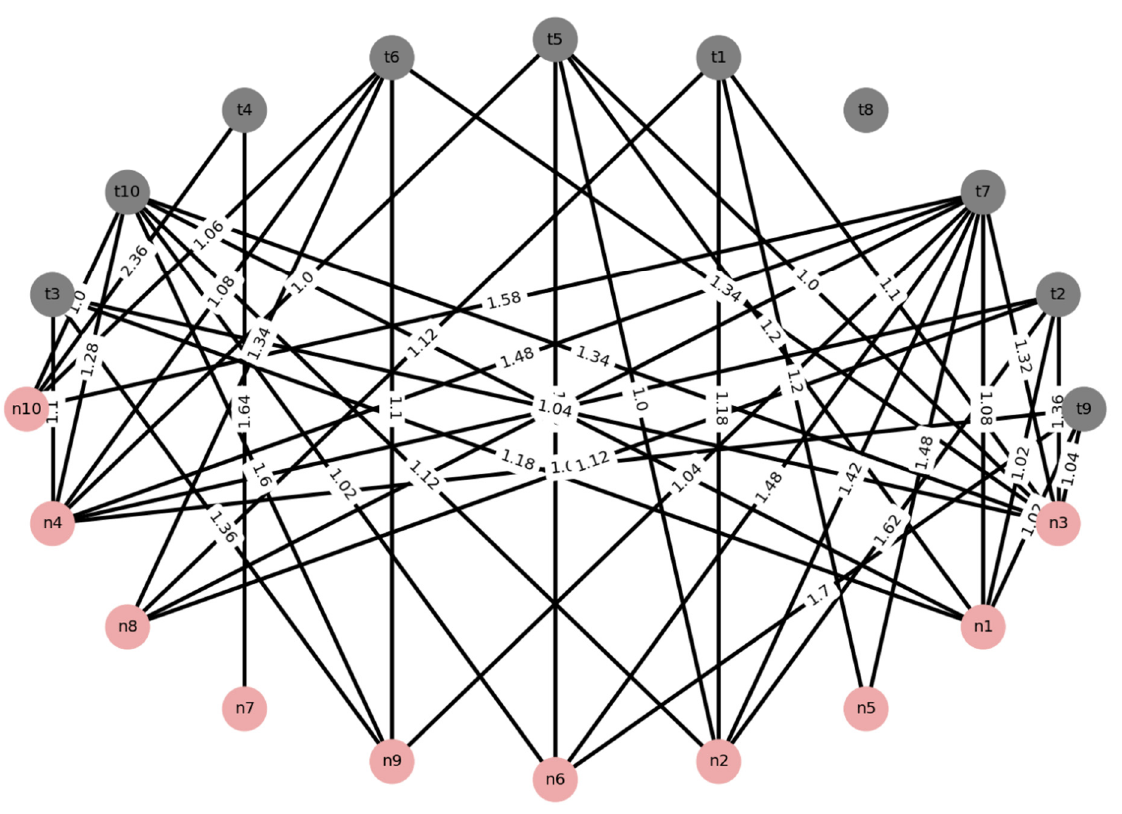
Figure 3. The network of topics present in the tweets and the news and their weighted level of re- latedness.